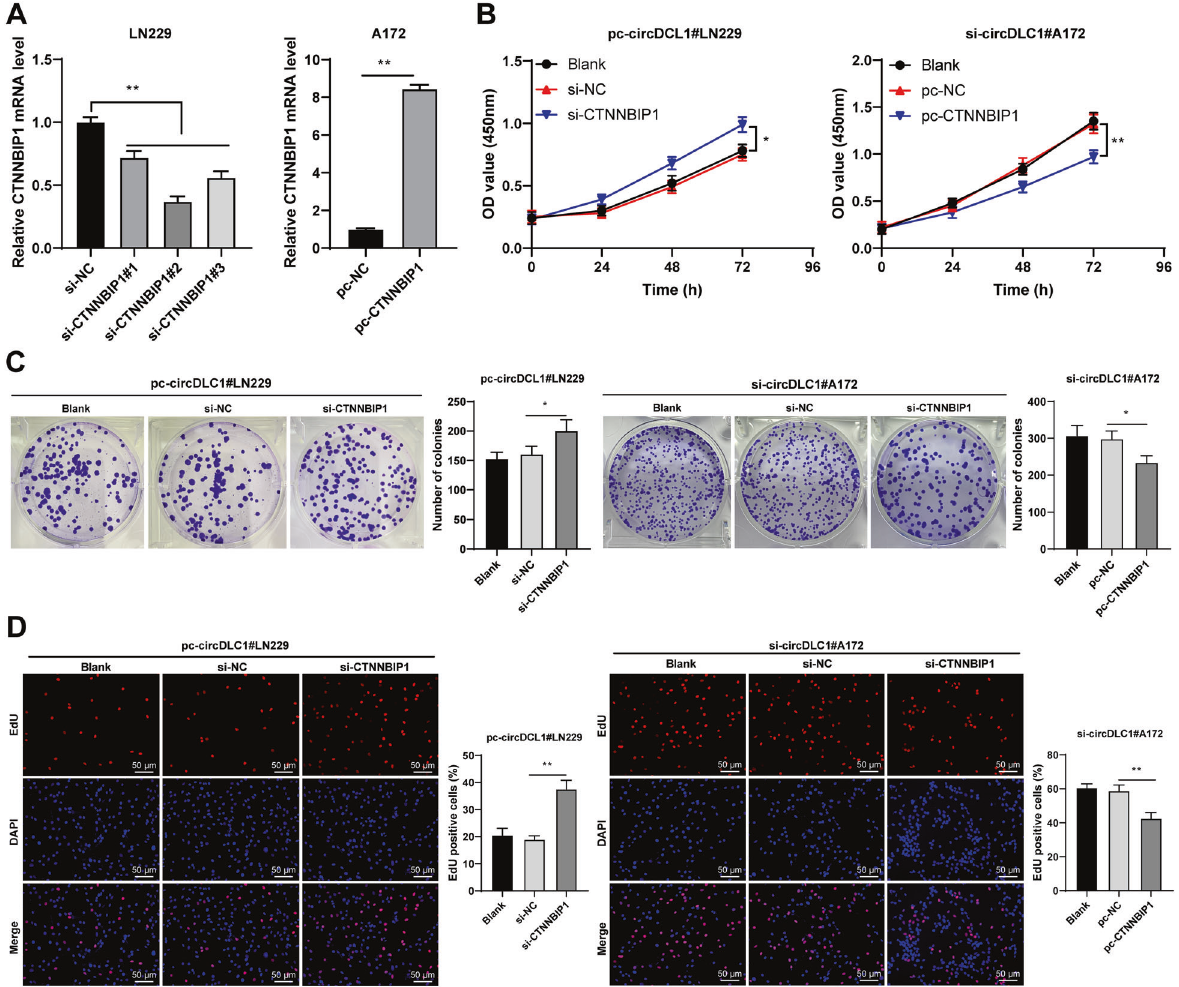
Fig. 6 CTNNBIP1 silencing attenuated the inhibitory effect of circDLC1 overexpression on malignant proliferation of glioma cells. Three CTNNBIP1 siRNAs (si-CTNNBIP1) were transfected into LN229 cells, with NC siRNA (si-NC) as control. CTNNBIP1 pcDNA 3.1 (pc-CTNNBIP1) was transfected into A172 cells, with NC pcDNA 3.1 (pc-NC) as control. A CTNNBIP1 mRNA expression was determined using RT-qPCR. B – D Cell proliferation was measured using CCK-8 assay ( B ), colony formation assay ( C ), and EdU staining ( D ). The cell experiment was repeated three times independently. Data are presented as mean ± standard deviation. The comparisons between two groups in panel A were analyzed using t -test. The comparisons among multiple groups in panels A / C , D were performed using one-way ANOVA, and the comparisons among multiple groups in panel B were analyzed using two-way ANOVA, followed by Tukey ’ s multiple comparisons test, * p < 0.05, ** p <